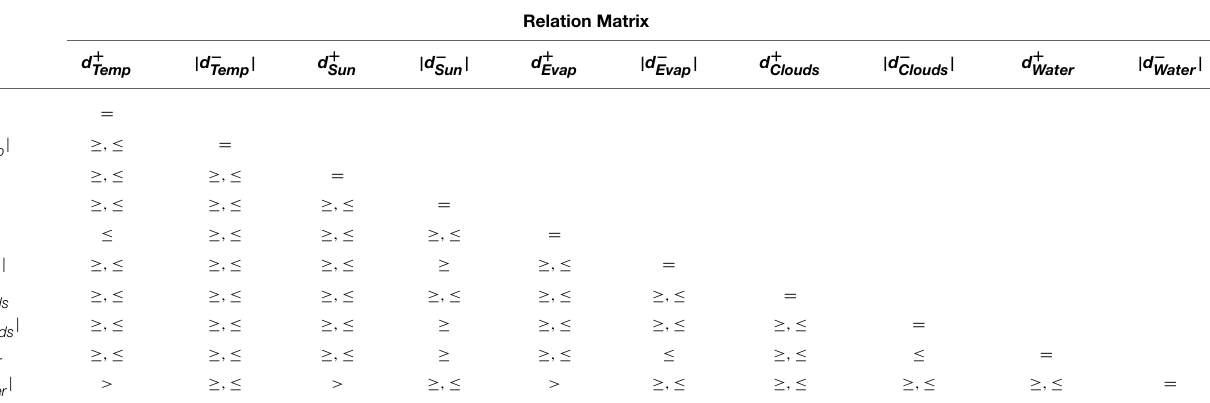
TABLE 4 | The relation matrix of Case Study 2.